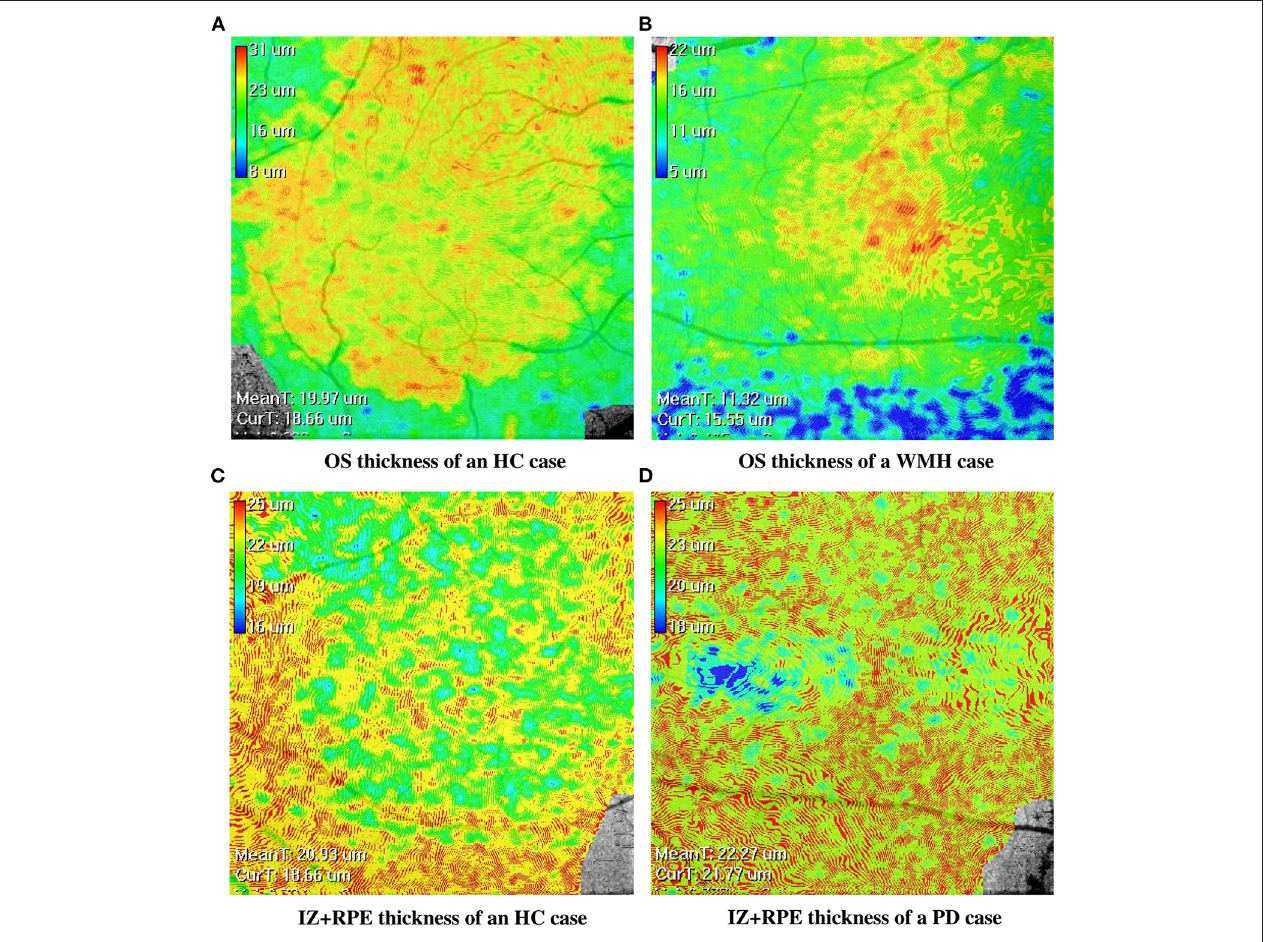
FIGURE 4 | The en-face retinal layer thickness maps of four cases from the WMH, PD and HC groups, respectively. (A,B) show the thickness distribution difference of the OS layer between the HC and WMH groups. (C,D) show the thickness distribution difference of the IZ+RPE layer between the HC and PD